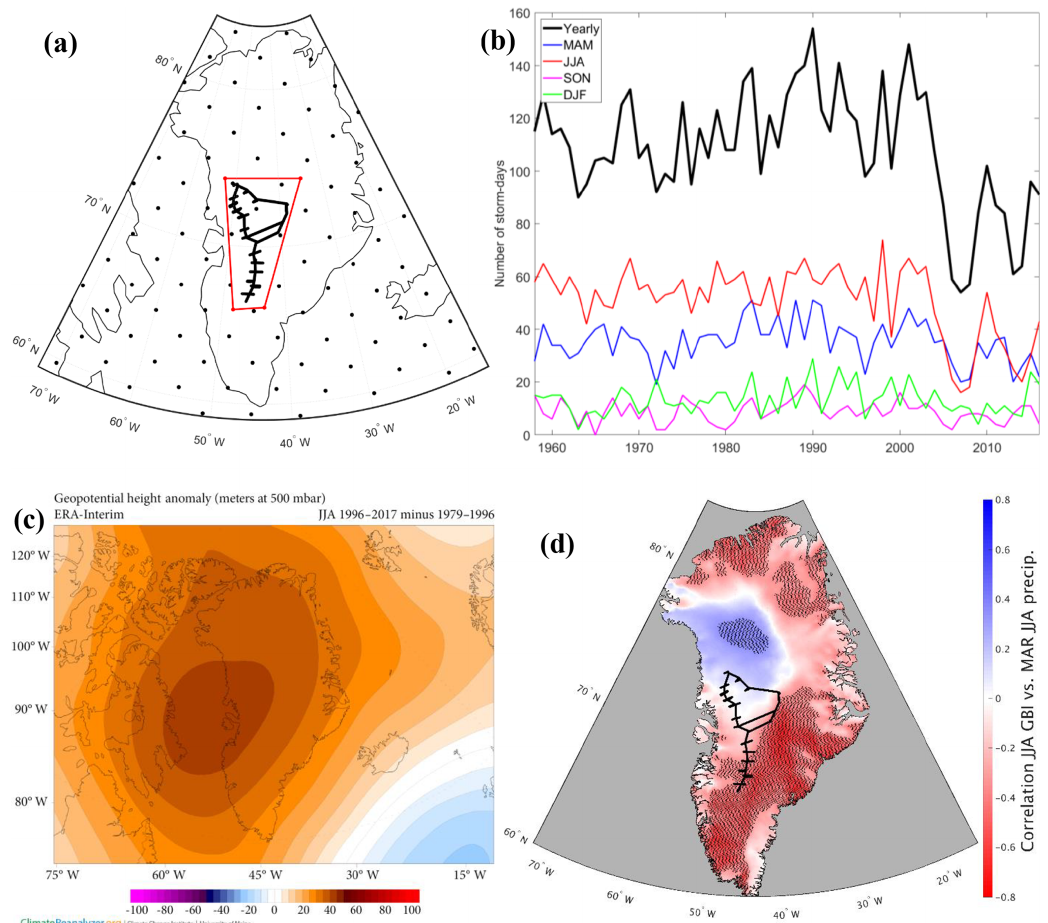
Figure 11. (a) Serreze (2009) gridded storm track dataset showing location of GreenTrACS traverse and inquiry box. (b) Total number of storm days within inquiry box for annual and seasonal periods. Horizontal black lines show a decrease in 1958–1996 to 1996–2016 average number of storm days within this region. (c) the 500mbar geopotential height change over Greenland showing 1996–2016 minus 1979–1996 for the summer season. Image obtained using Climate Reanalyzer (http://cci-reanalyzer.org, last access: 1 February 2019), Climate Change Institute, University of Maine, United States. (d) Correlation between June–August Greenland Blocking Index and MAR June–August precipitation. Statistically significant RCM grid cell correlations are stippled black. GreenTrACS traverse is shown in black.